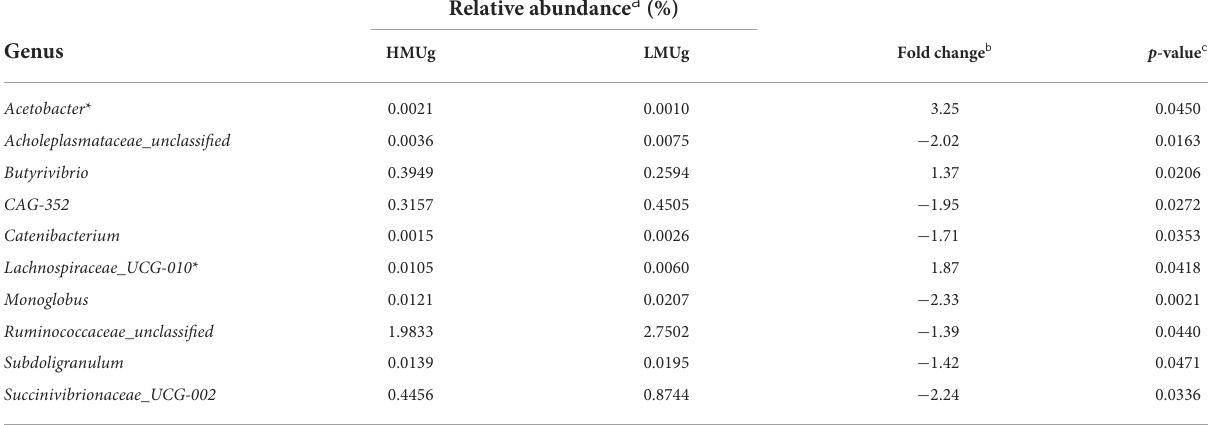
TABLE 1 Significantly differentially abundant genera (DAG) in the rumen of HMUg and LMUg cows. Relative abundance a